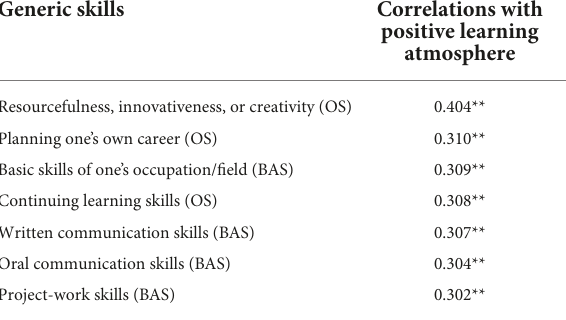
TABLE 2 Associations between a perceived positive learning atmosphere and learning of the generic skills (Pearson Correlation Coefficient).